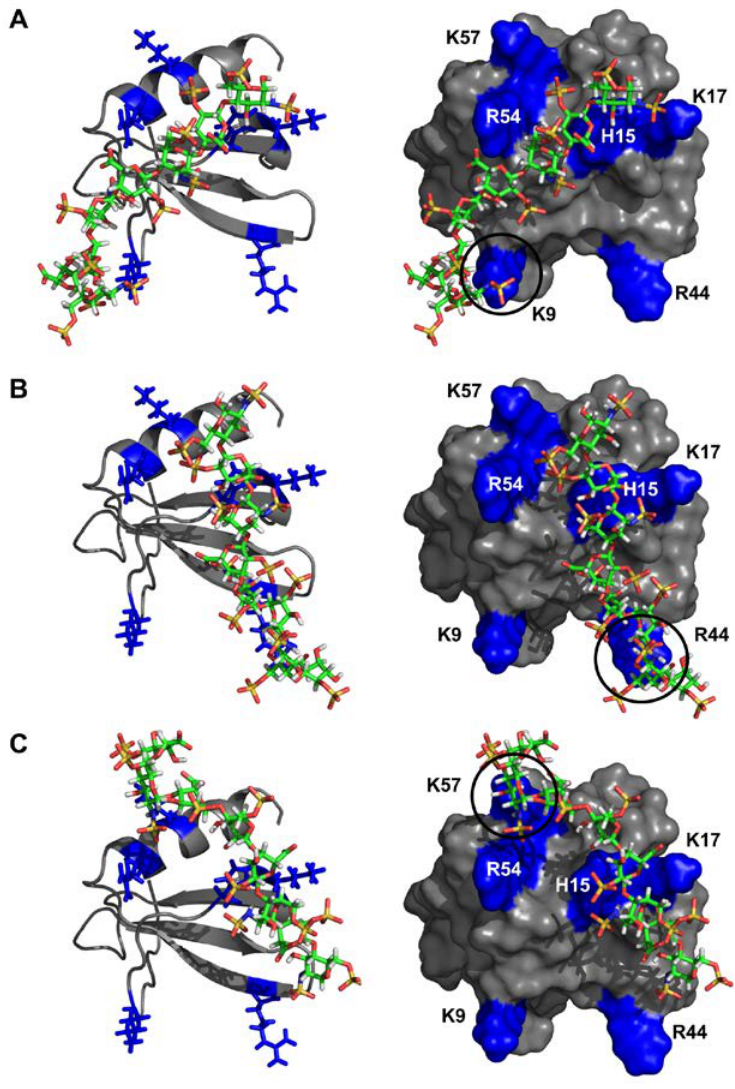
Figure 7. Models of the CXCL7-GAG heparin complexes. Different binding geometries that arise due to differences in peripheral interactions are shown in panels A , B , and C, respectively. The left column shows the ribbon diagram of the CXCL7 monomer, with GAG and positively-charged side chains shown as sticks. The right column shows the surface plots. Arg, Lys and His residues are highlighted in blue and labeled. Black circles highlight peripheral residues that mediate the binding geometry.